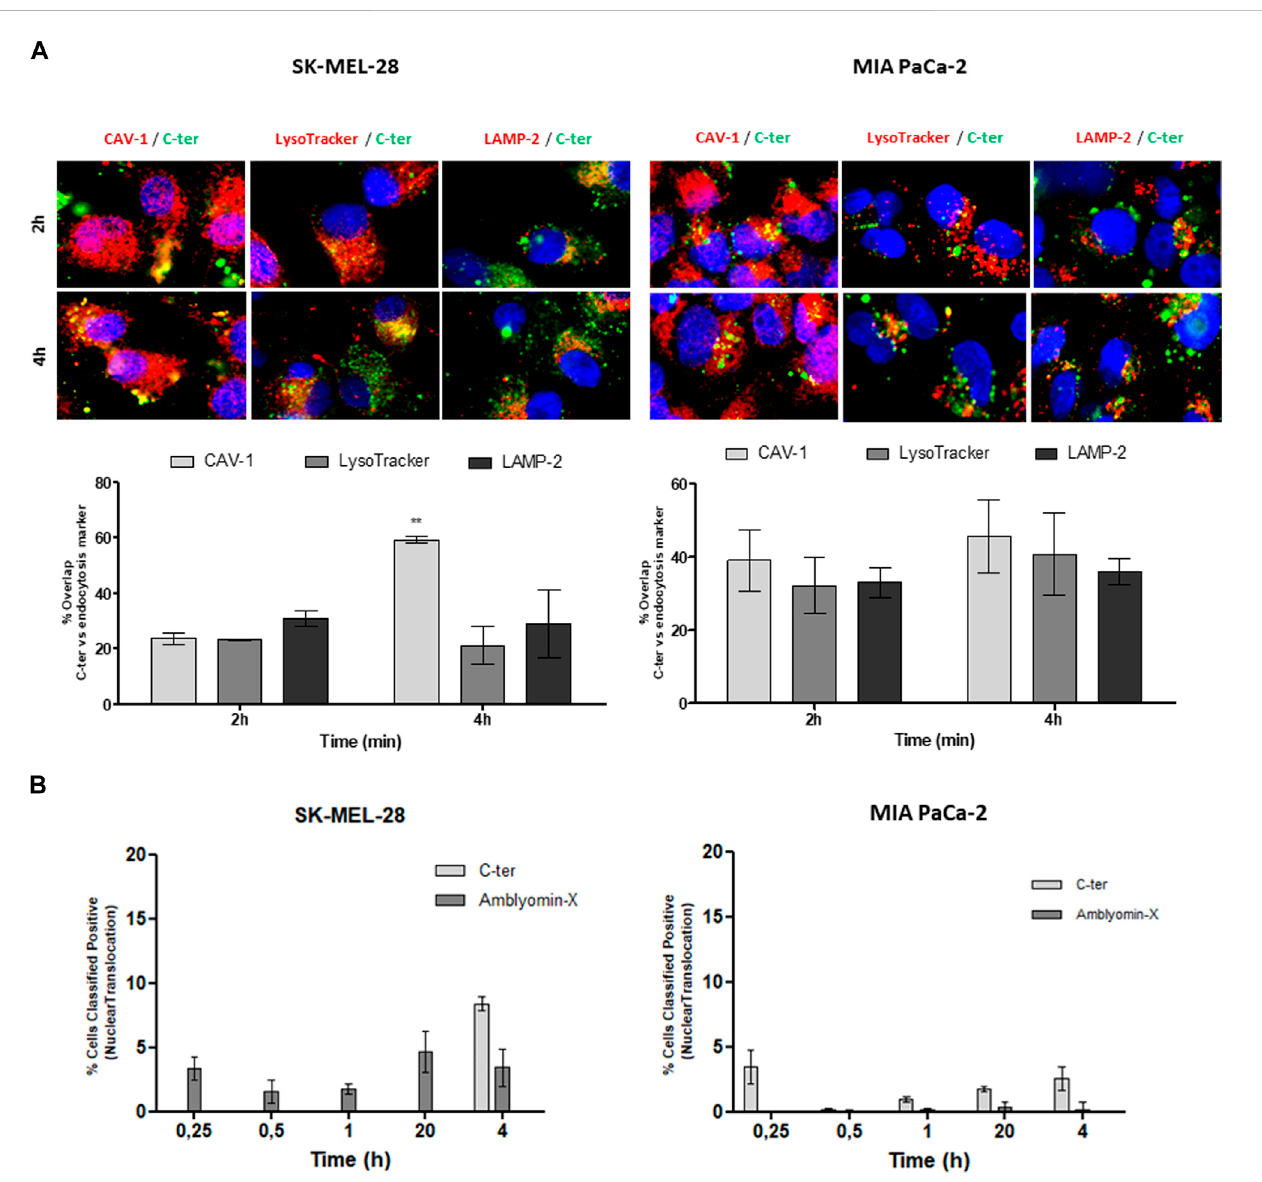
FIGURE 5 Participation of caveolin-mediated endocytosis and lysosomes in C-ter intracellular traf fi cking. (A) Tumor cell lines were treated with 488-C-ter at the indicated. After, cells were incubated with aprimary antibody against caveolin-1 or LAMP-2, followedby a secondary antibody conjugated to Alexa Fluor 555. Also, after treatment, cells were then incubated with LysoTracker Red DND 99 (100 nM) in the binding medium at 37 ° C for 20 min. Then, green and red fl uorescences were monitored by a Molecular Devices ImageXpress Micro Confocal plate-scanning microscope. Nuclei stained with Hoechst 33342. The percentage of cells positive for nuclear translocation (B) and overlap between C-ter and intracellular markers were analyzed using MetaXpress software (Molecular Devices, Sunnyvale, CA). Values are mean ± SD of three independentexperiments (each one carried out using nine fi elds per well and in triplicate). * p ≤ 0.05; ** p ≤ 0.01 and *** p ≤ 0.001 (comparing % of overlap between 488-C-ter-488 and intracellular markers at each time of treatment). % Classi fi ed Positive Nuclear translocation (the number of cells classi fi ed as positive for translocation divided by the total cell count, times 100) was calculated by using Translocation Application Module of MetaXpress software (Molecular Devices, Sunnyvale,